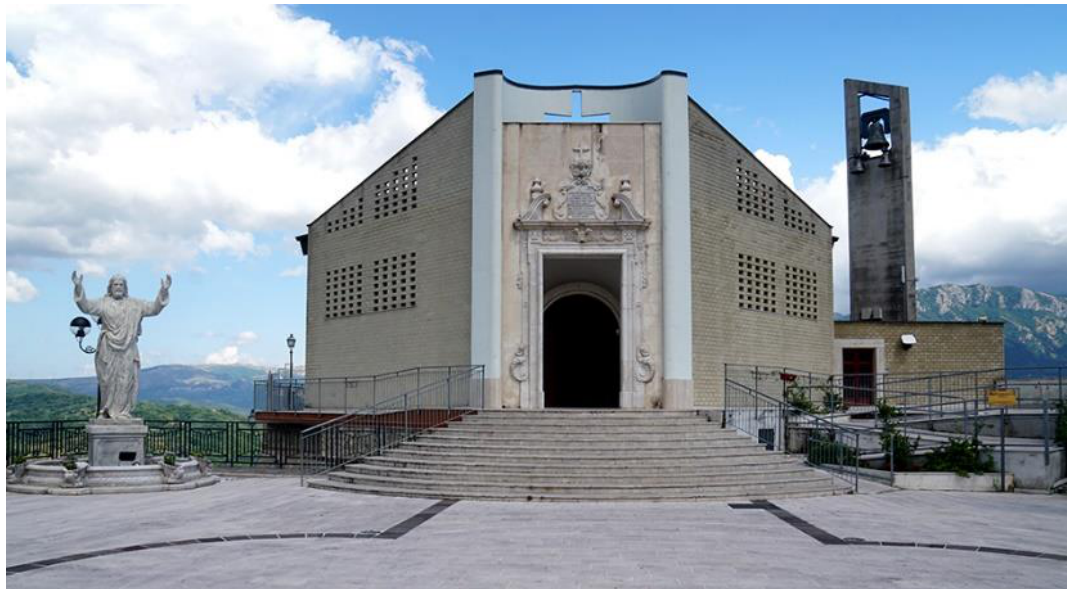
Figure 49. Calabritto: The new Church of Santissima Trinità (photos by [35,36]).